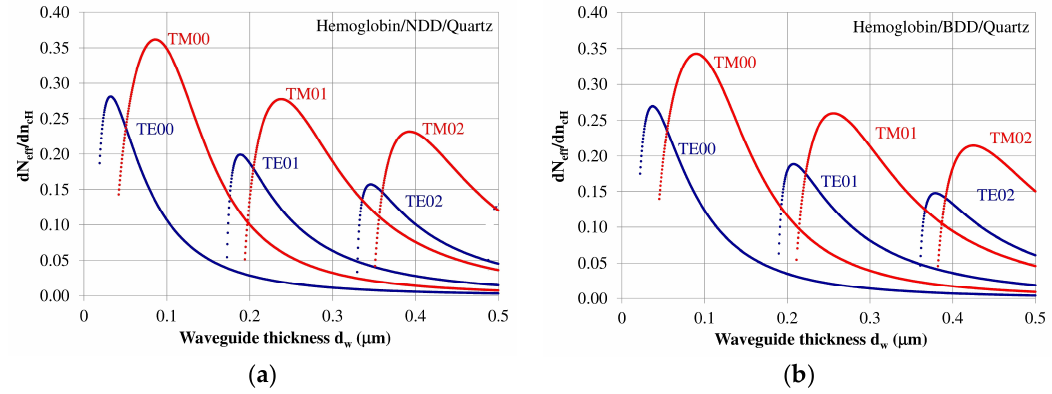
Figure 4. Homogeneous sensitivity dN eff / dn cH for the ( a ) undoped diamond (NDD) and ( b ) boron-doped diamond (BDD) waveguide structures.